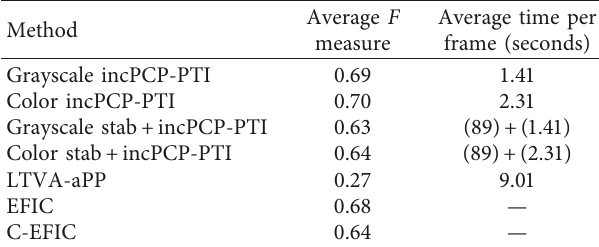
Table 6: Value of F measure for grayscale and color incPCP-PTI and stab+ incPCP-PTI on the IP video.